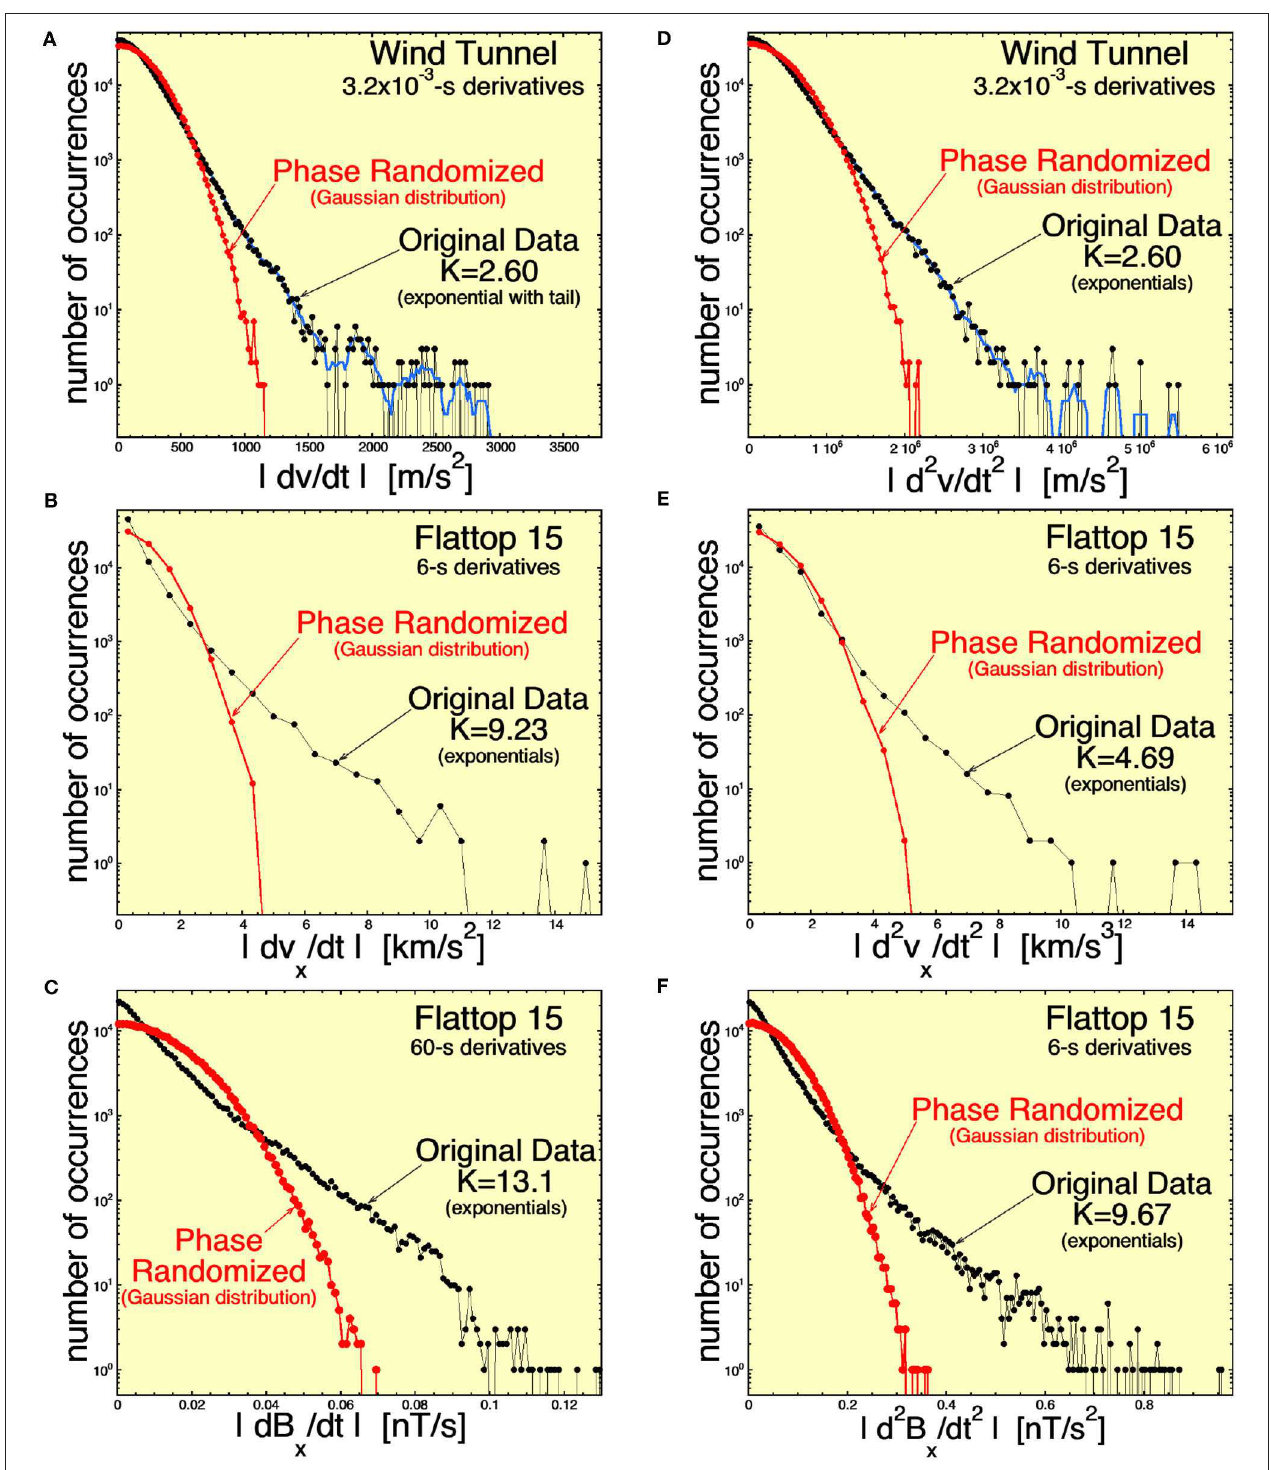
FIGURE 6 | Distributions of the measured first time derivatives (A–C) and second time derivatives (D–F) for (A,D) the streamwise velocity v in the wind tunnel Navier–Stokes turbulence, (B,E) the radial (from the Sun) velocity v x for the Alfvénic solar wind fluctuations of Flattop 15, and (C,F) the radial component of the magnetic field B x for the Alfvénic solar wind fluctuations of Flattop 15. The black curves are time derivatives in the measured time series, and the red curves are time derivatives in phase-normalized versions of the measured time series. The time derivatives are over a timescale pertaining to the higher-frequency portion of the inertial subrange. For the original-data distributions, the kurtosis K of the signed values is noted.